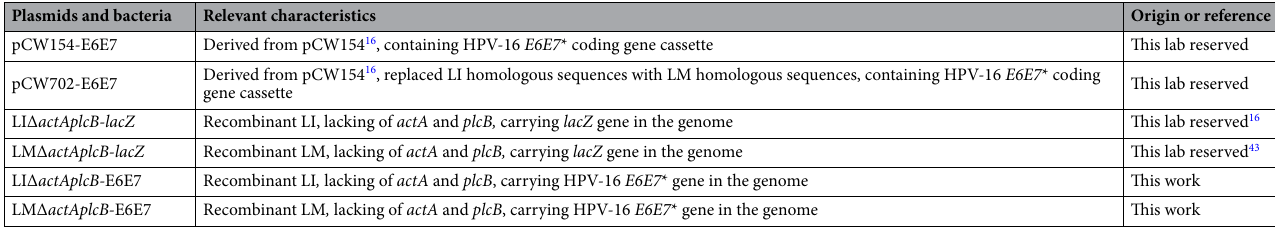
Table 1. Plasmids and bacteria strains used in the present study. E6E7 *, the arrangement of E6 and E7 genes was intentionally shuffled, by alternatively placing the N- and C-terminal domains of the two genes, but with an overlapping region of 16 amino acids 17